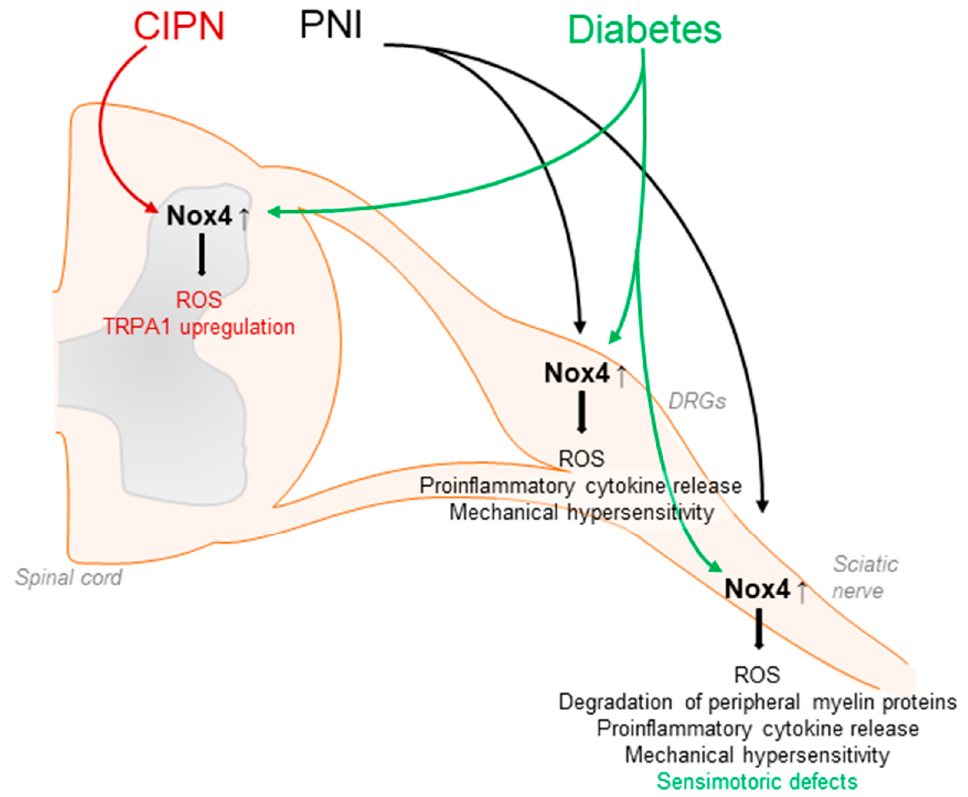
Figure 3. Contribution of Nox4 to neuropathic pain signaling. Nox4 is expressed in primary afferent neurons and Nox4-derived ROS induce the degradation of peripheral myelin proteins in peripheral nerves after injury, leading to mechanical hypersensitivity. Similar effects are observed in diabetic models. Furthermore, Nox4 promotes ROS production and proinflammatory cytokine release in DRGs and the sciatic nerve. CIPN: chemotherapy-induced peripheral neuropathy; PNI: peripheral nerve